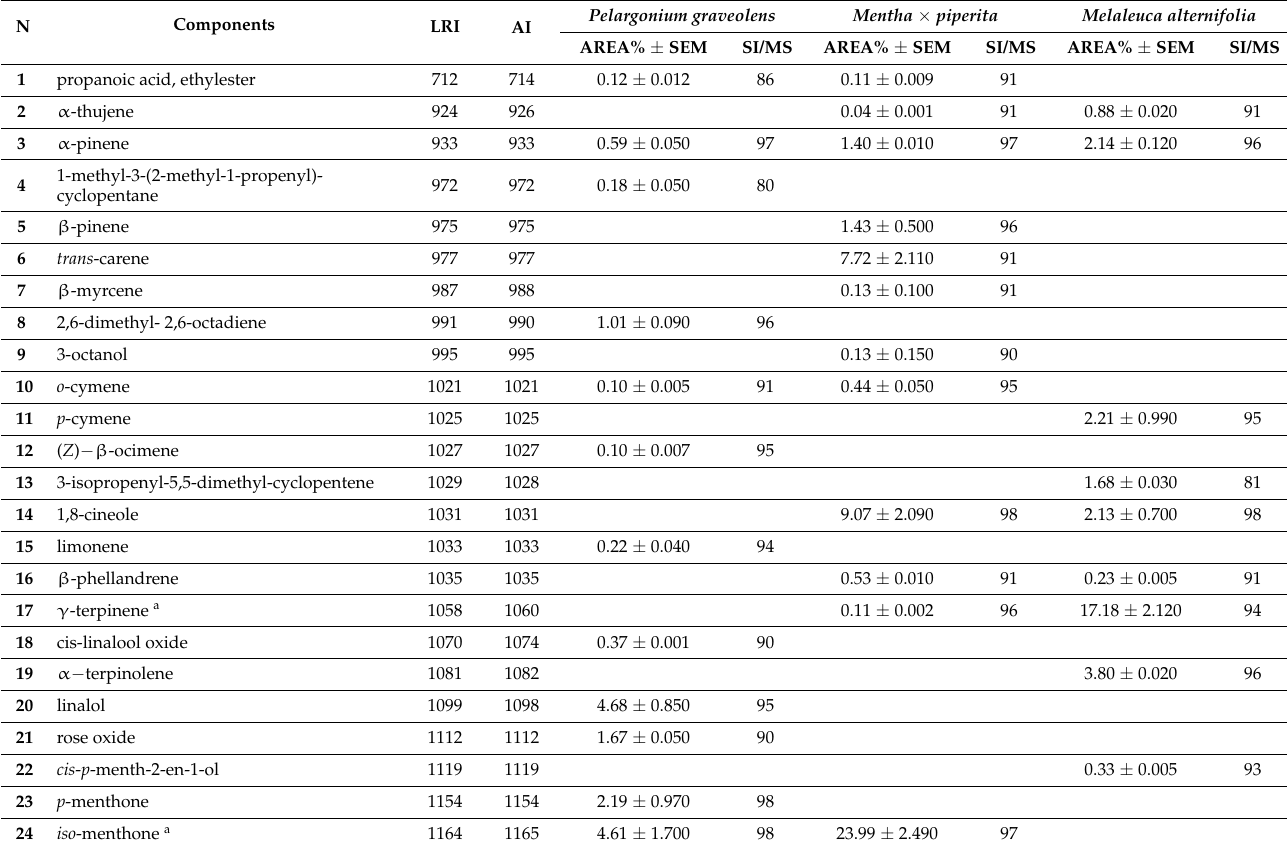
Table 1. Chemical composition of tested Essential Oils